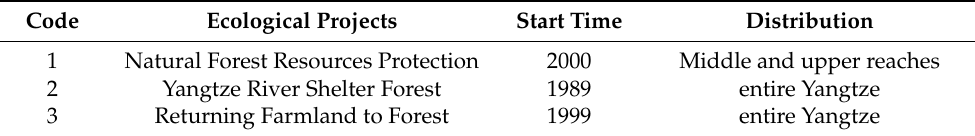
Table 3. Characteristics of the forest ecological projects in the Yangtze River basin.